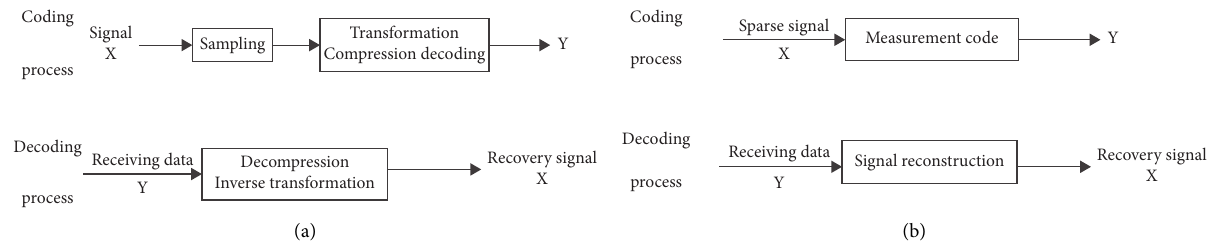
Figure 1: The comparison results of encoding and decoding process. (a) Based on Nyquist sampling theorem. (b) Based on compressed sensing theory.